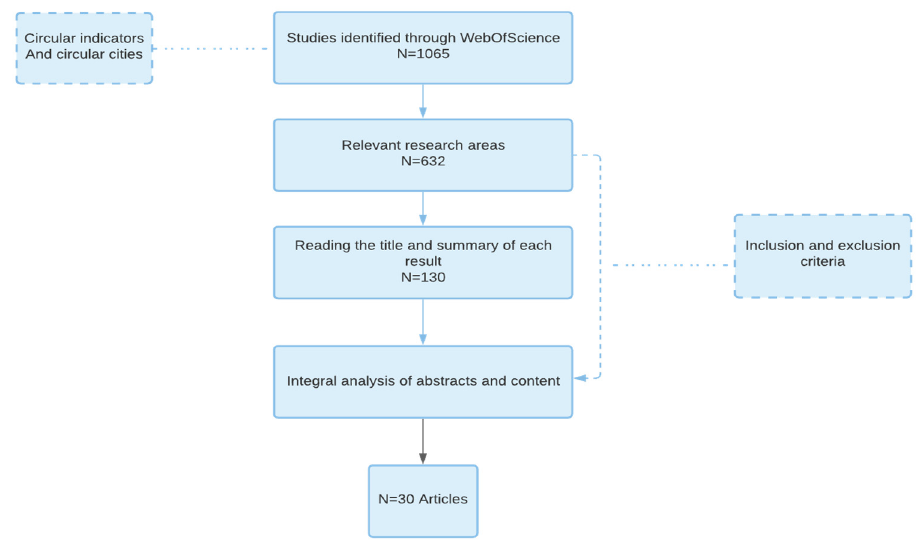
Figure 2. The study selection